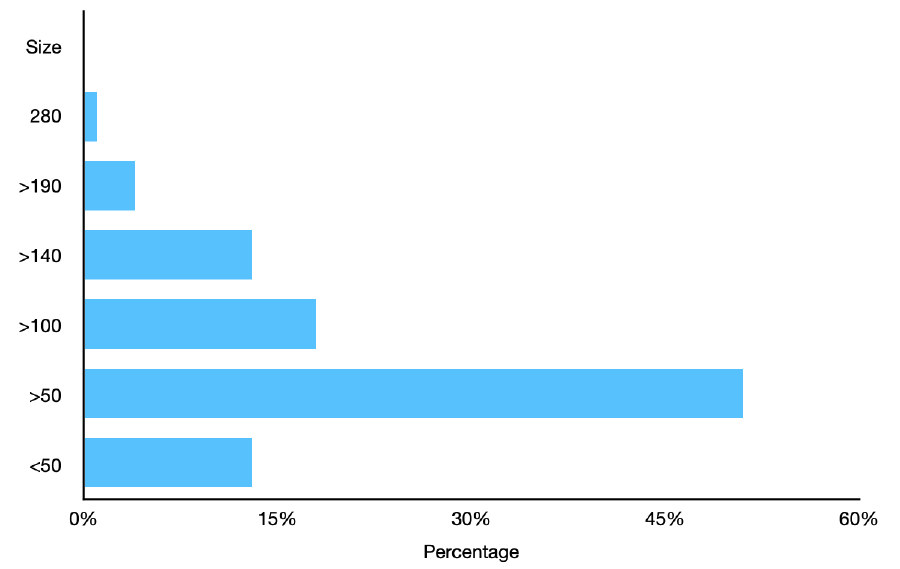
Figure 2. Percentage of sizes of collected